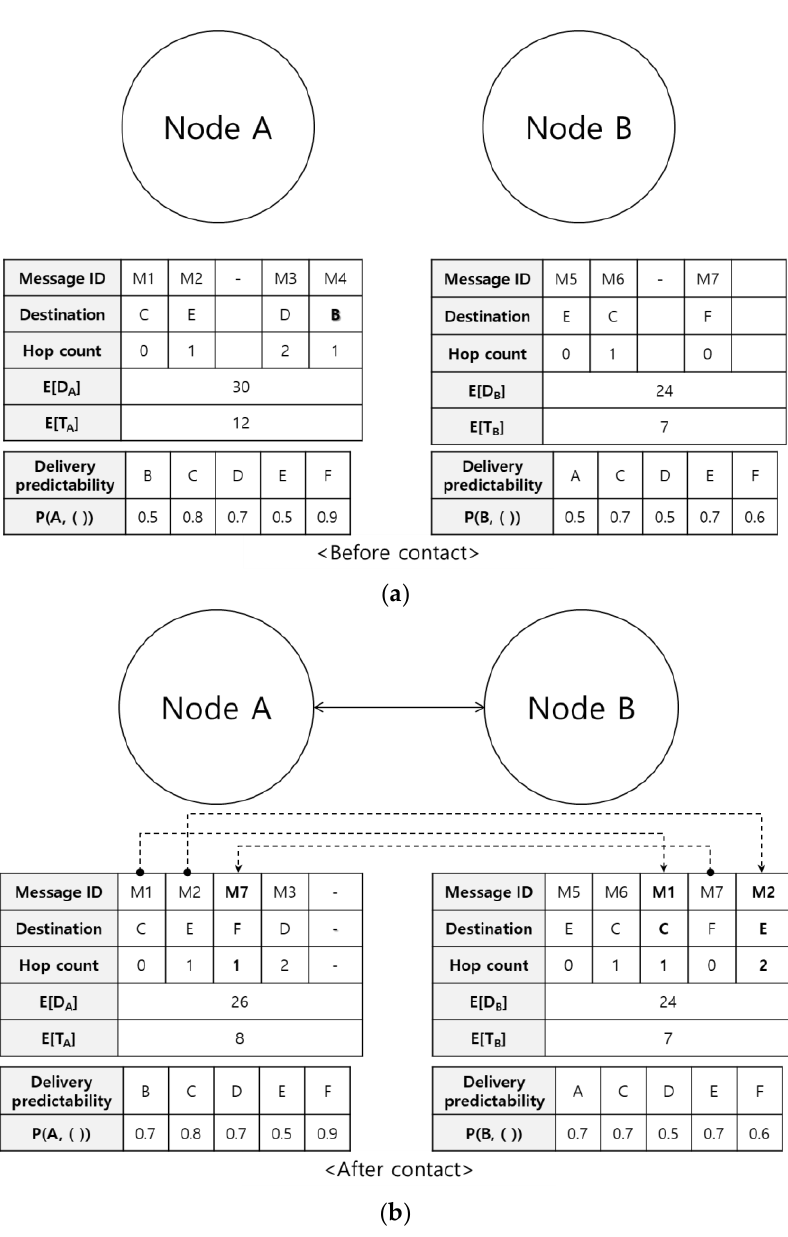
Figure 4. An example of message deliver: ( a ) before contact, ( b ) after contact.